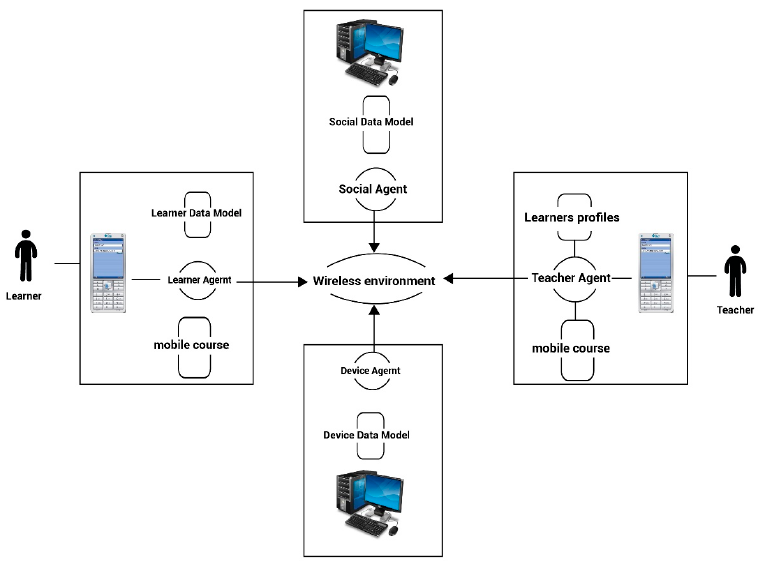
Figure 5. Collaborative mobile-learning model based on agents.